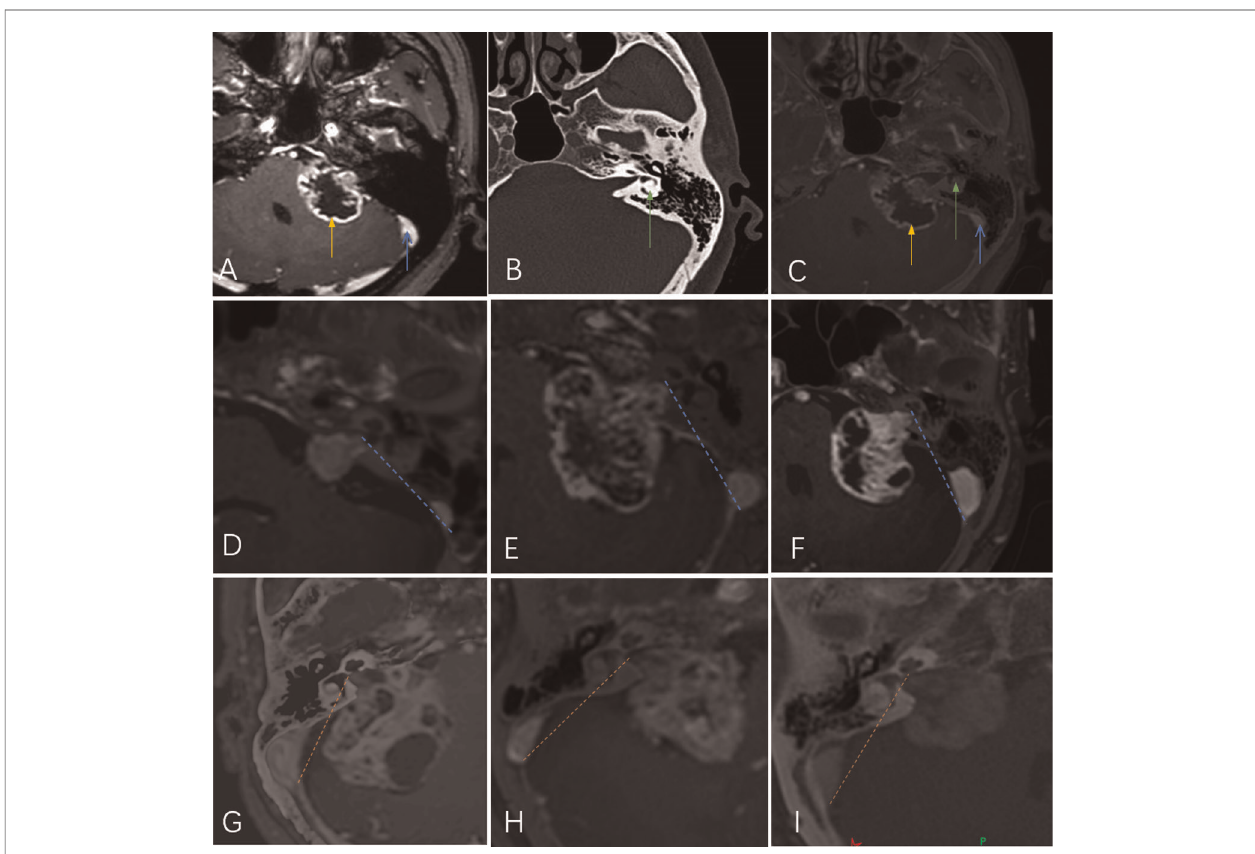
FIGURE 1 | ( A ) Magnetic resonance imaging shows the tumor (yellow arrow) and sigmoid sinus (blue arrow). ( B ) Computed tomography shows the labyrinth (green arrow). ( C ) The fused image shows the positions of all three simultaneously. The line between the outermost edge of the tumor and the medial side of the sigmoid sinus was de fi ned as the lateral safe line (LSL; yellow- or blue-dotted line). Tumors were classi fi ed according to the relationship between the LSL and the labyrinth: lateral type ( D,E,F ) and medial type ( G,H,I